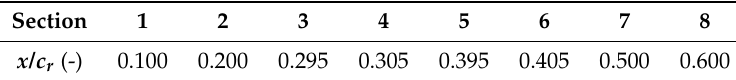
Table 3. Chordwise sections for surface pressure